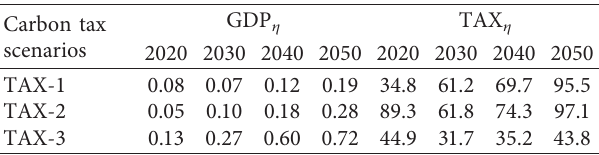
Table 6: Impact of different carbon tax levels on the macro- economy of the power industry. Carbon tax scenarios